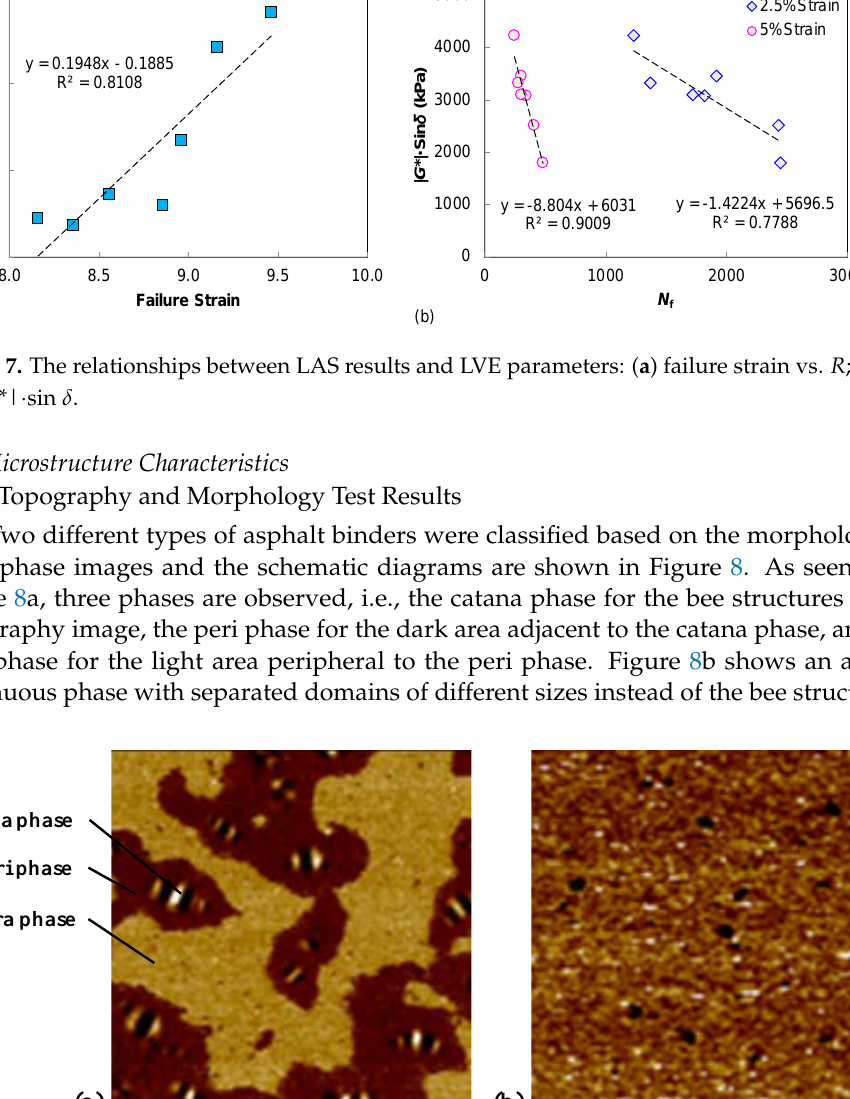
Figure 8. Schematic diagrams for different microstructures: ( a ) three phases; ( b ) a continuous phase.